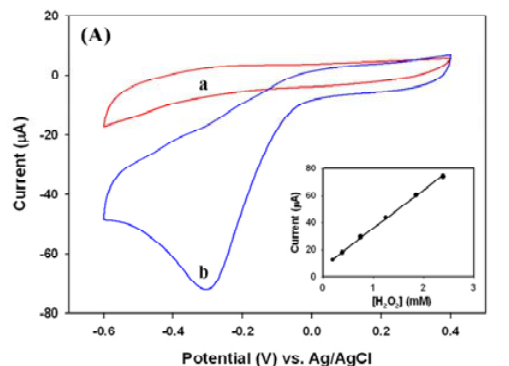
O (red) 2 2 O (blue). Inset indicated the linear correlation of 2 2 O . (B) The SEM image of 2 2